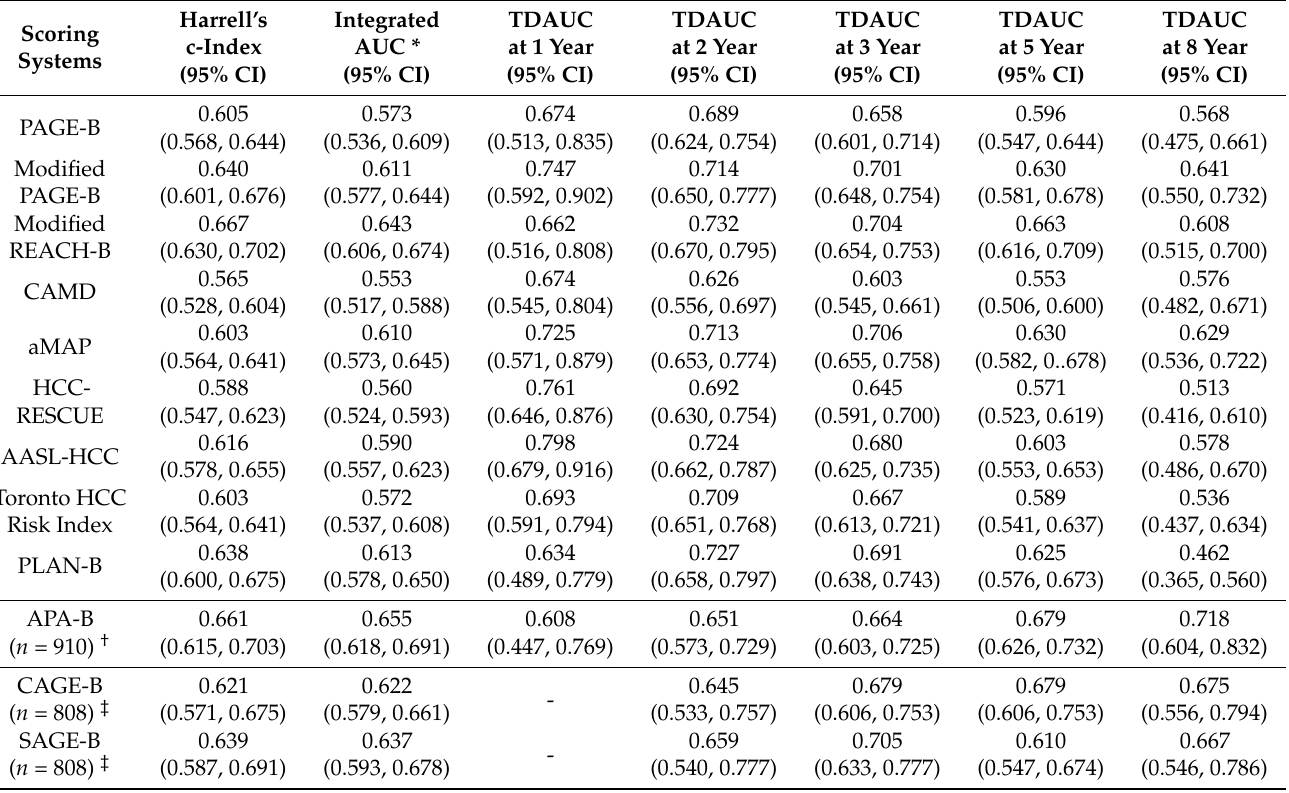
Table 4. Predictive performance of the risk prediction